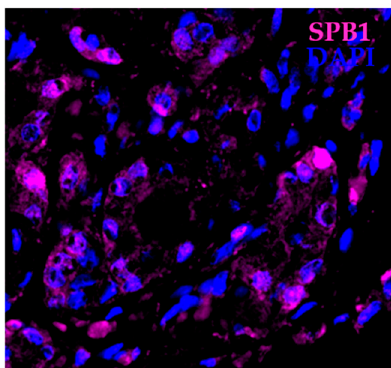
Figure 1. Localization of SBP1 in prostate cancer. Human prostate cancer tissue showing cells that express SBP1 (magenta) mostly in the cytoplasm and several cells that express SBP1 in the nucleus. Nuclei are highlighted with DAPI (blue).